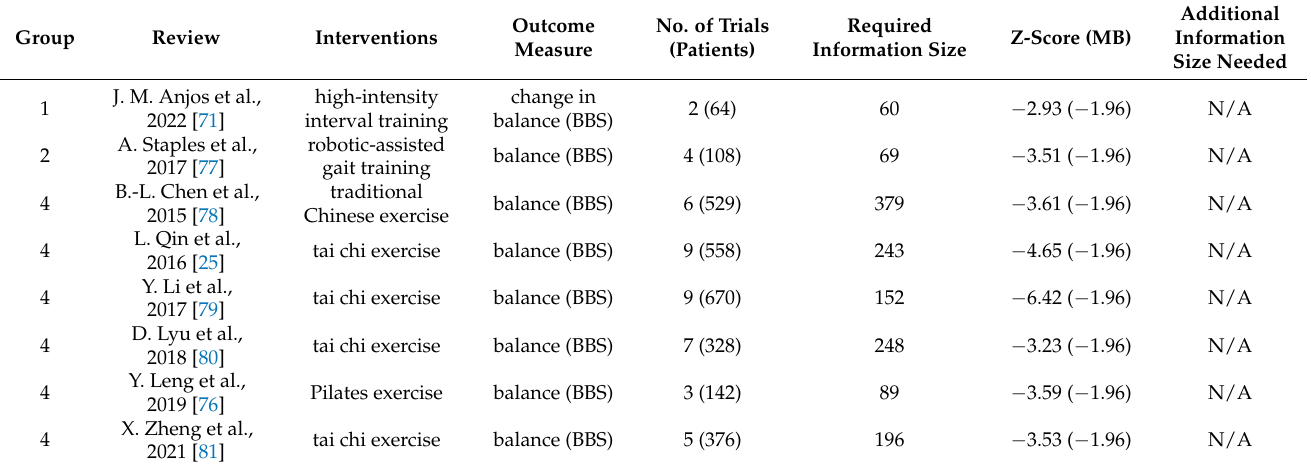
Table 9. Studies with verified intervention effects on balance function